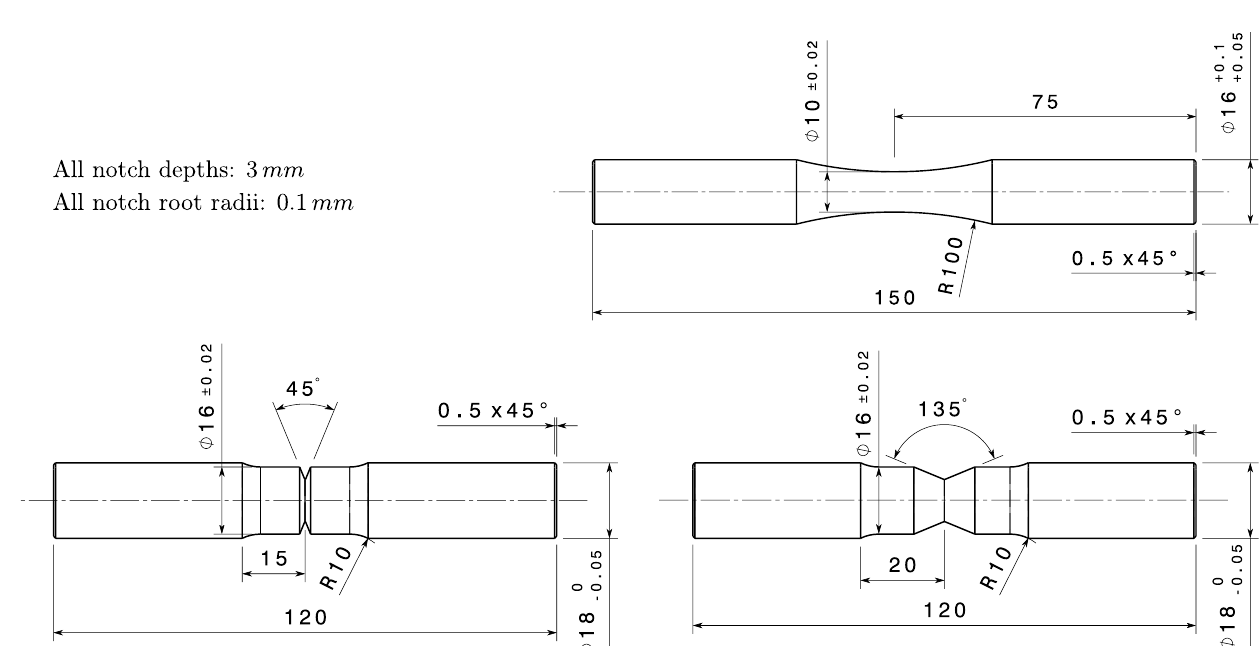
Figure 3. Small–scale specimen geometries utilized for fatigue strength evaluation.